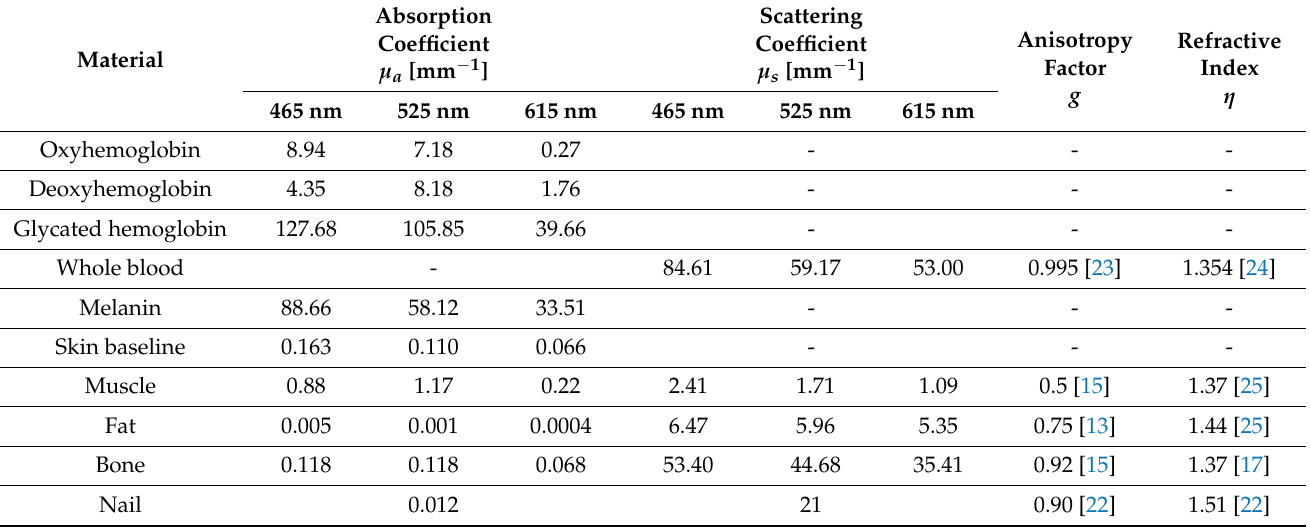
Table 2. Optical properties of the biomaterials at three wavelengths (465 nm, 525 nm, and 615 nm).